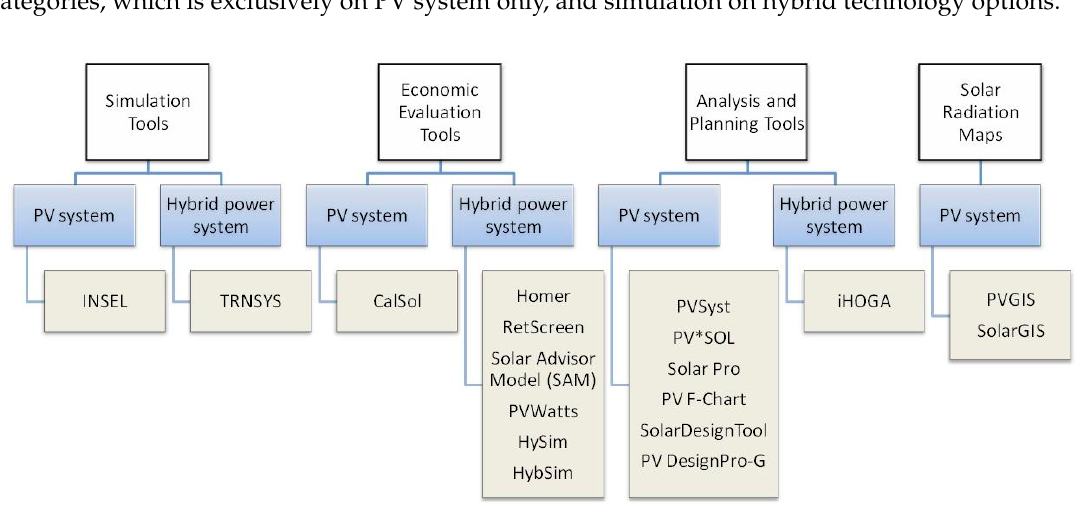
Figure 2. Classification of simulation software based on its application.